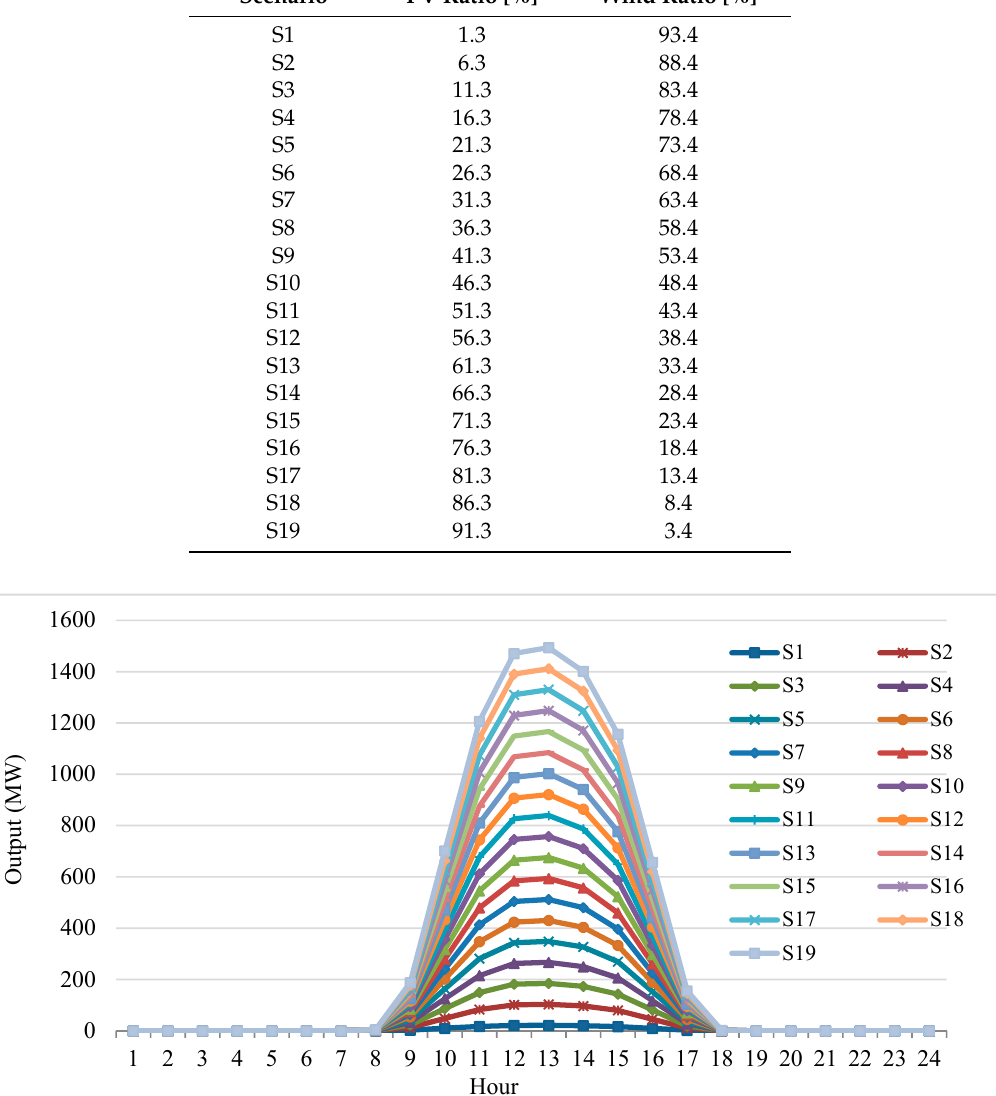
Figure 5. Output profile of PV according to the VGR mix scenarios.